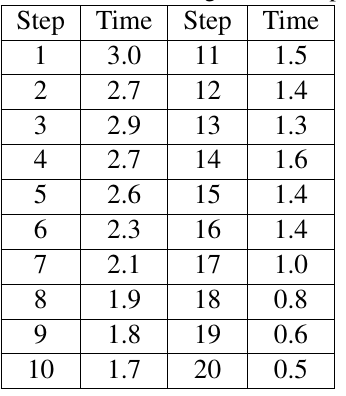
Table 3 time consuming of each